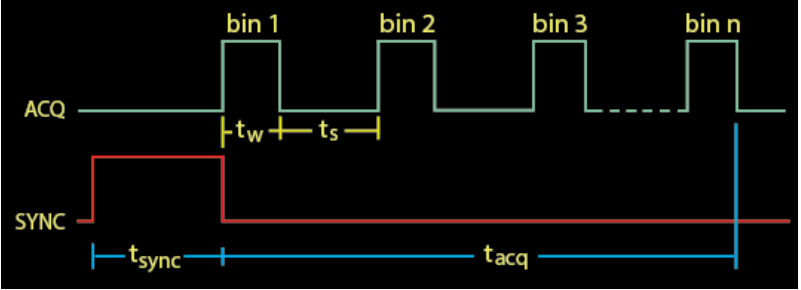
Figure 4. Timing sequence diagram for a delayed fluorescence experimental sequence.